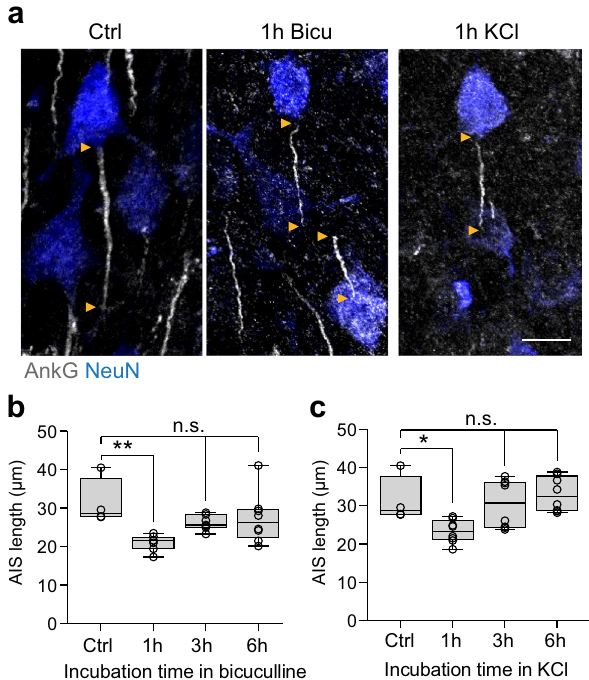
Fig. 6 Rapid AIS length shortening in acute slices after 1 h of increased activity. a Representative confocal images of layer II/III neurons in S1BF of acute slices that were subjected to 1 h of KCl (8 mM) or bicuculline (Bicu, 15 µ M) treatment. Note the shorter AIS length in comparison to Ctrl conditions. Scale bar 10 µ m. b Population analysis of AIS length in layer II/III S1BF after exposure to Bicu: 1 h leads to a shortening of AIS length (One- way ANOVA ** P = 0.010, Dunnett ’ s multiple comparisons test ** P = 0.0040). AIS length returns to baseline after 3 h and 6 h of Bicu treatment. N = 4 slices for Ctrl, n = 7 independent experiments for 1, 3 h; n = 8 independent experiments for 6 h, slices derived from 2 mice, > 200 AIS/ condition. c Population analysis of AIS length in layer II/III S1BF after exposure to elevated extracellular KCl: 1 h leads to shortening of AIS length (One-way ANOVA ** P = 0.0044, Dunnett ’ s multiple comparisons test * P = 0.035). AIS length returns to baseline after 3 h and 6 h of KCl treatment. N = 4 biologically independent experiments for Ctrl, n = 8 biologically independent experiments for 1, 3, 6 h, slices derived from 2 mice, > 200 AIS/condition. Boxplots: median with 25 – 75% interval, error bars show minimum to maximum